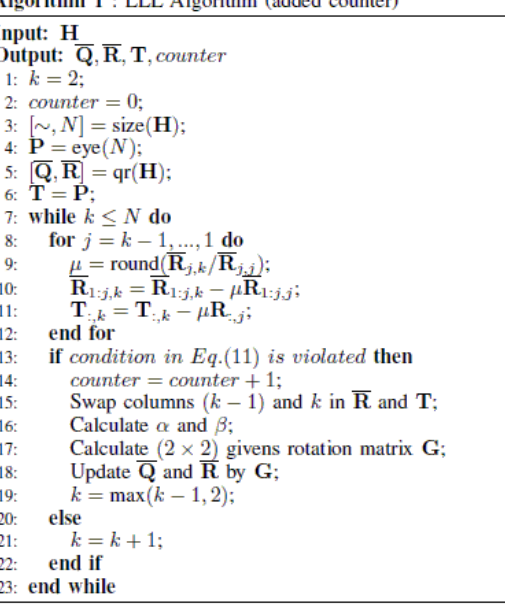
Fig. 3. Constellation of x.